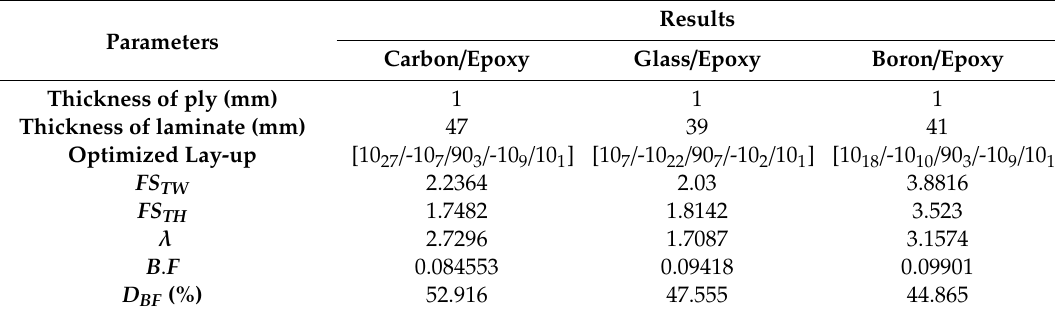
Table 6. Optimal lay-ups for [10 S / -10 T / 90 U / -10 V / 10 W ].